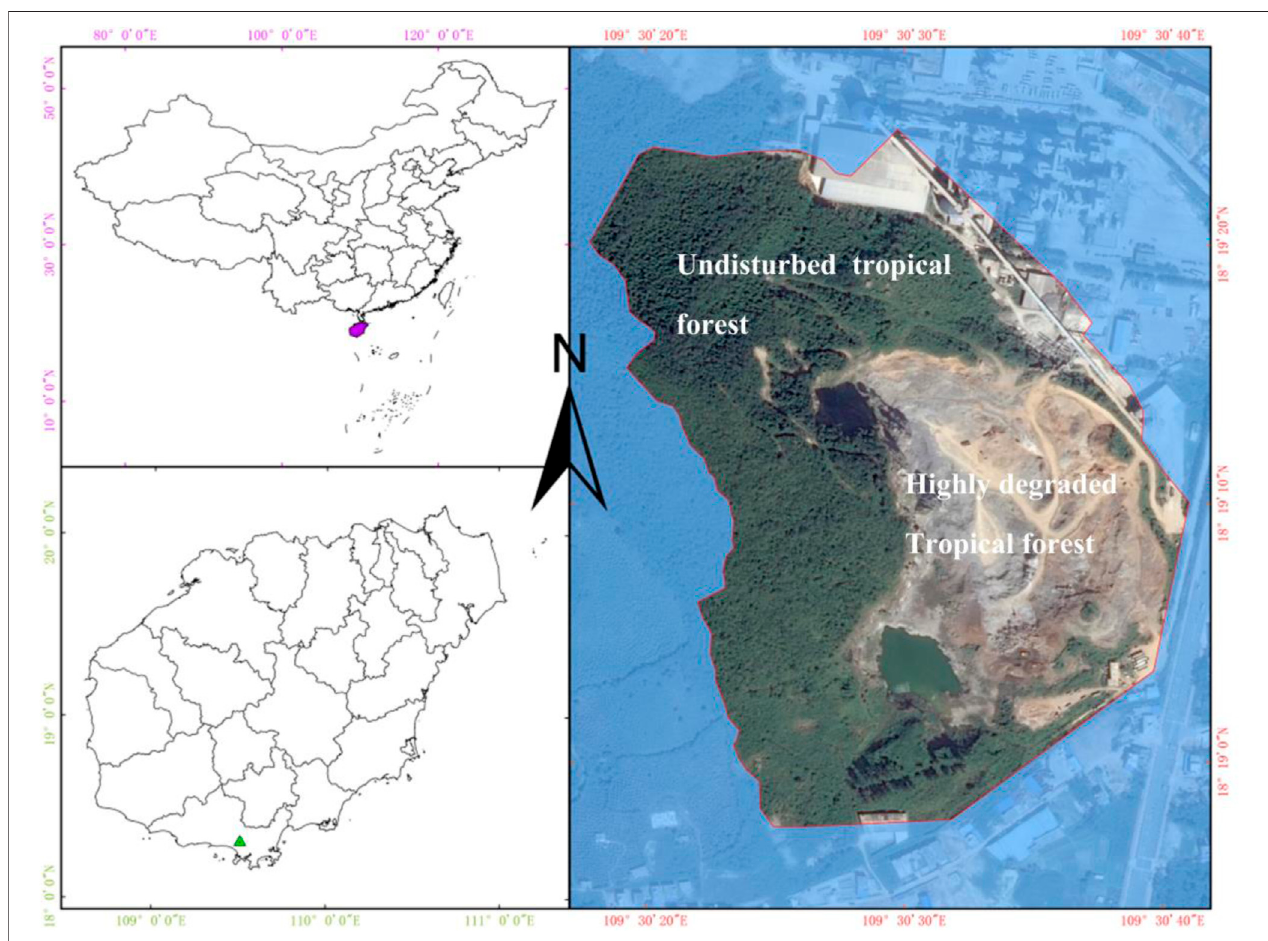
FIGURE 1 | Location and landscape of our study sites (Baopoling Mountain, Sanya, China) before reforestation.